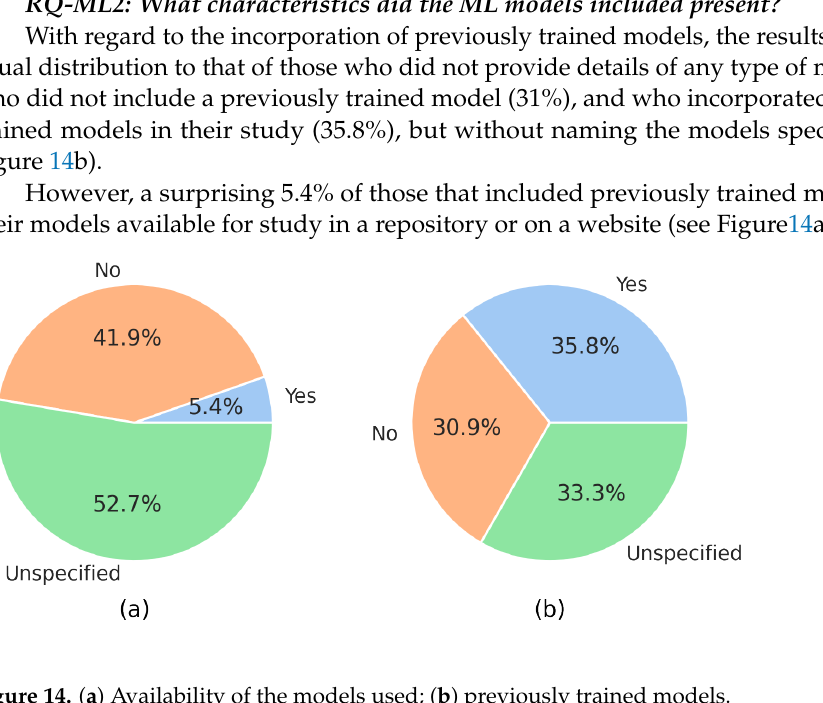
Figure 14. ( a ) Availability of the models used; ( b ) previously trained models. RQ-ML3: What were the main characteristics of the datasets